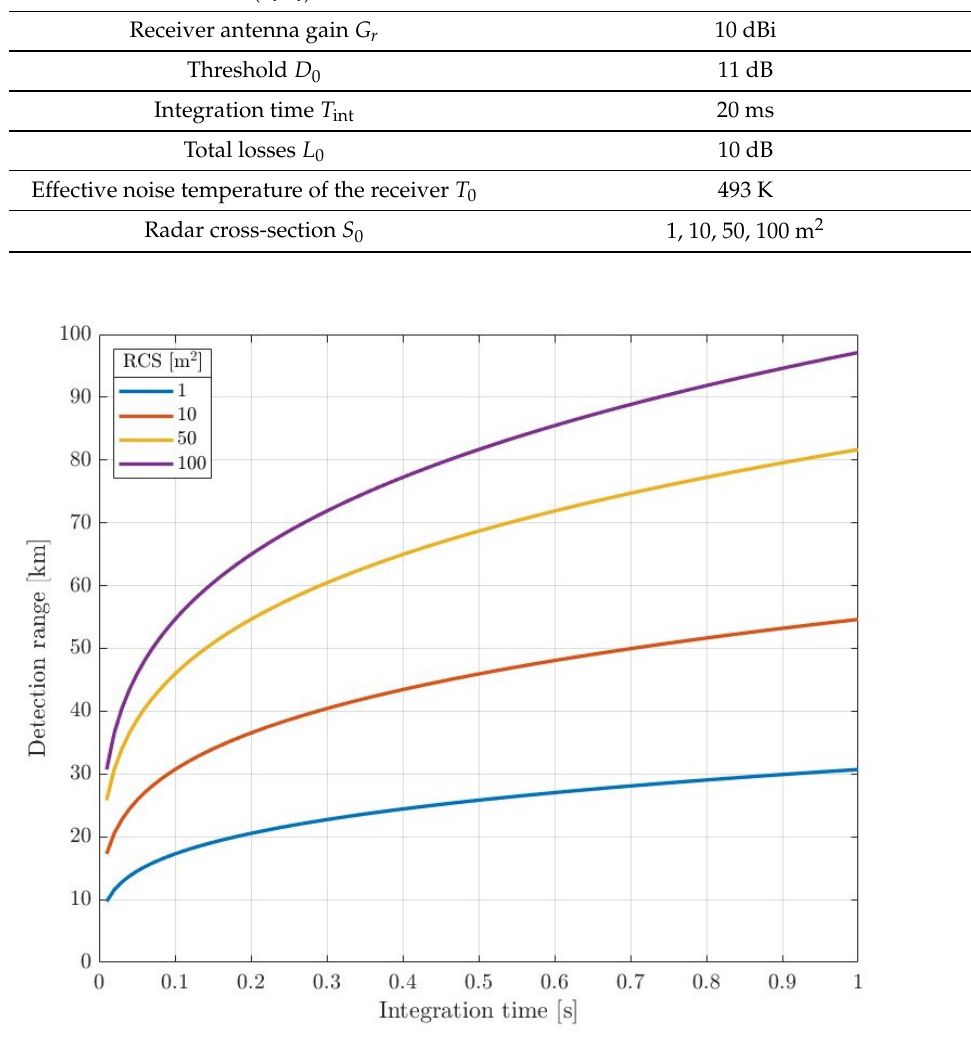
Figure 14. Plot range—integration